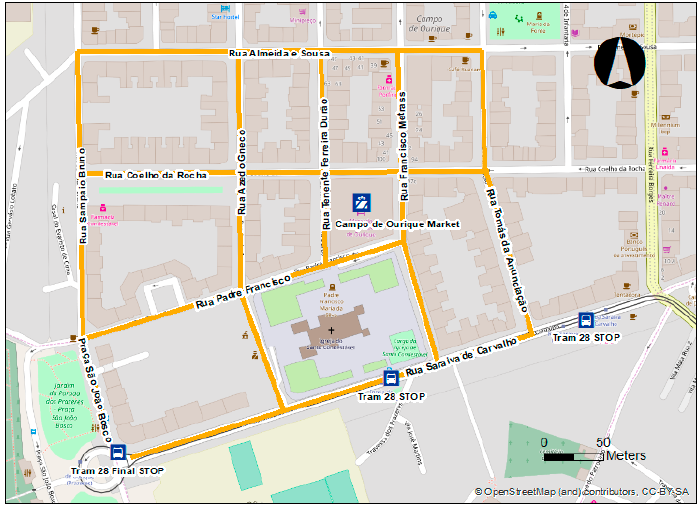
Figure 1. Streets where interviews were performed. Source: OpenStreetMap. Treatment performed by the author.